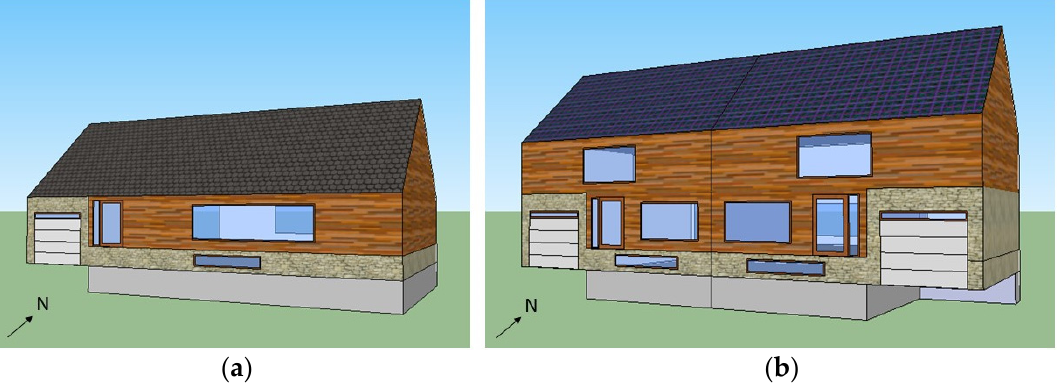
Figure 2. Schematic showing the two modeled houses [7]: ( a ) single-story existing house; ( b ) two two-story solar houses built on the same land lot (they can be semi-detached or spaced with a small distance).